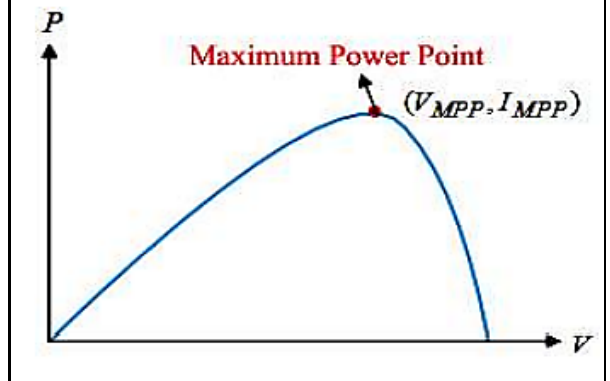
Figure 1. P–V characteristics of PV Cell.